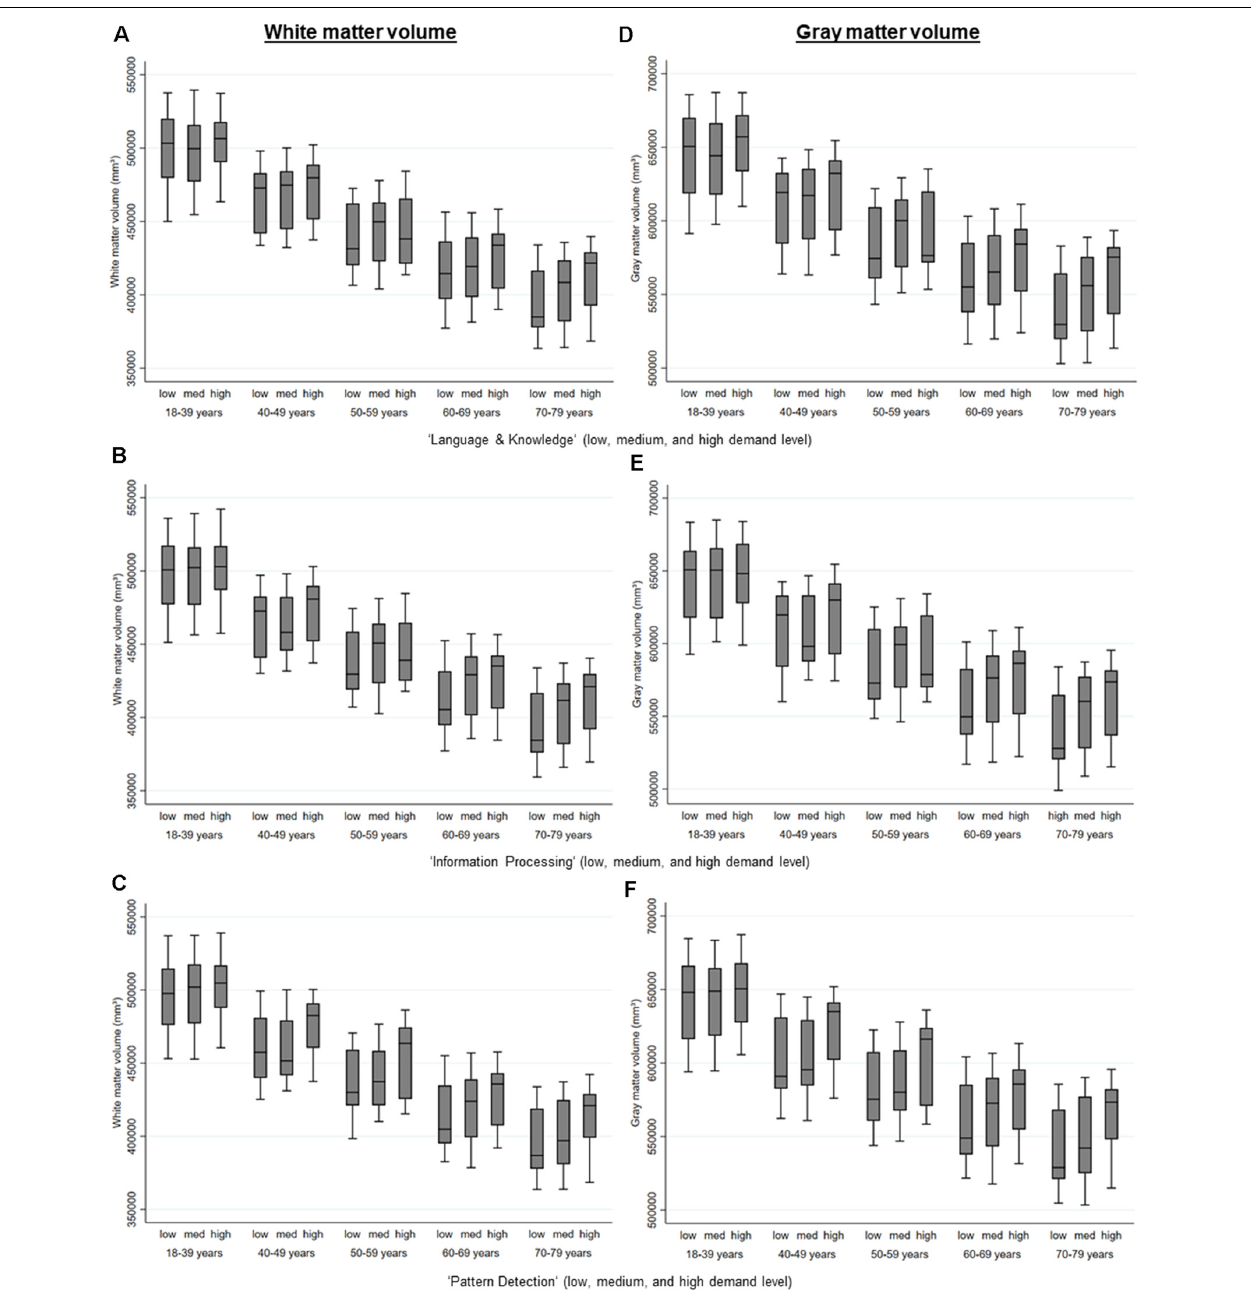
FIGURE 2 | White matter and gray matter volume by the level of MDW and age, estimated via regression analyses separate for those that are retired and those that are not retired and adjusted for age, gender, education, APOE e4-allele, hypertension, and diabetes. (A) Level of the mental work demand, Language & Knowledge on white matter volume. (B) Level of the mental work demand, Information Processing on white matter volume. (C) Level of the mental work demand, Pattern Detection on white matter volume. (D) Level of the mental work demand, Language & Knowledge on gray matter volume. (E) Level of the mental work demand, Information Processing on gray matter volume. (F) Level of the mental work demand, Pattern Detection on gray matter